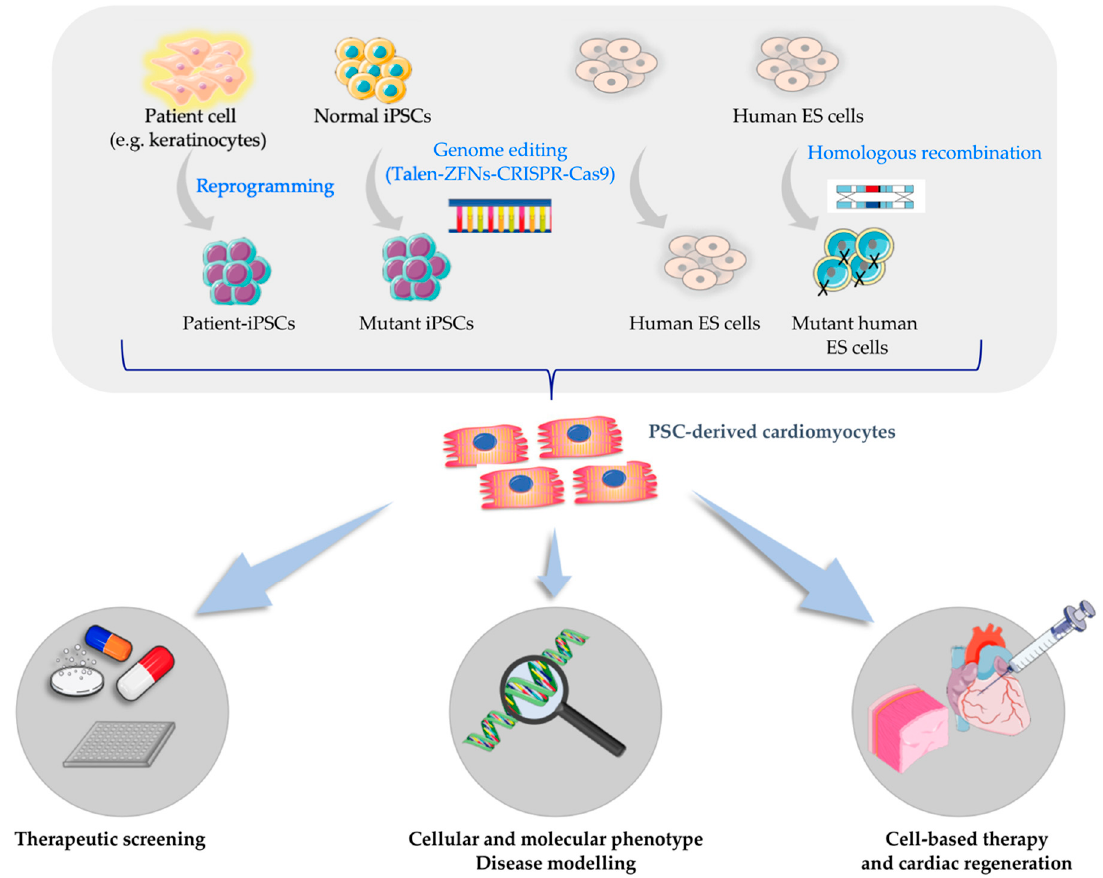
Figure 2. Biomedical applications of human pluripotent stem cells.